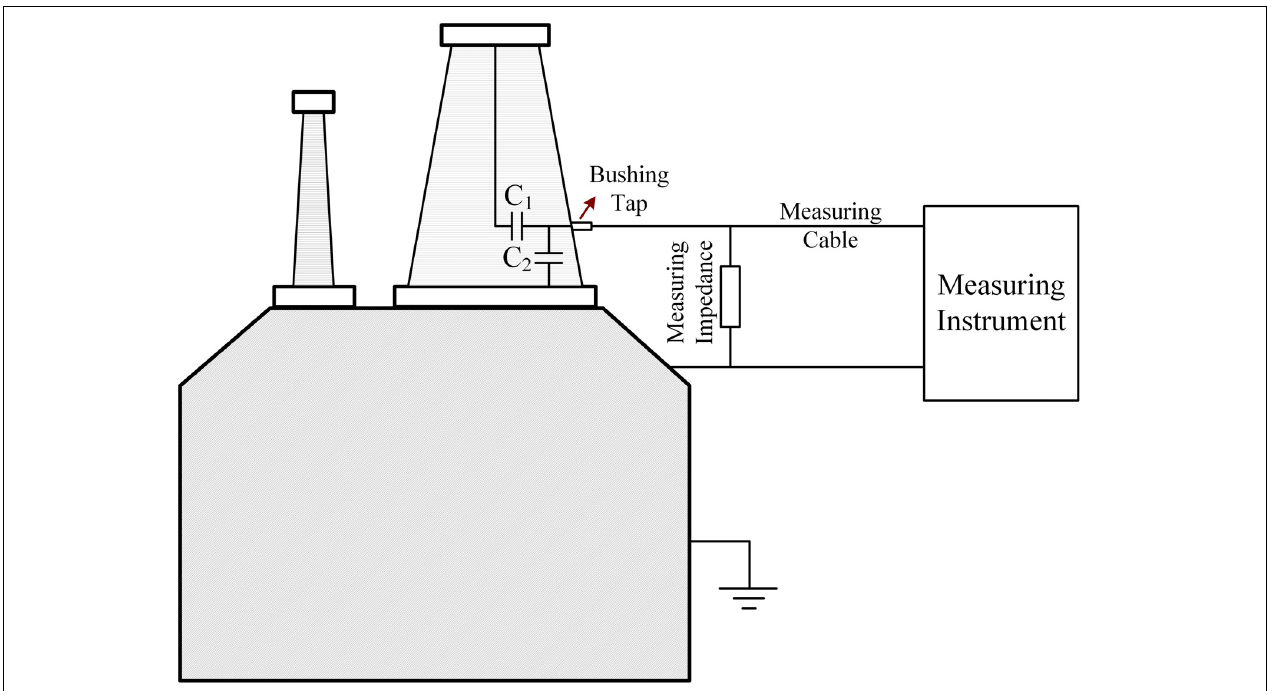
FIGURE 3 | An example of partial discharge measuring